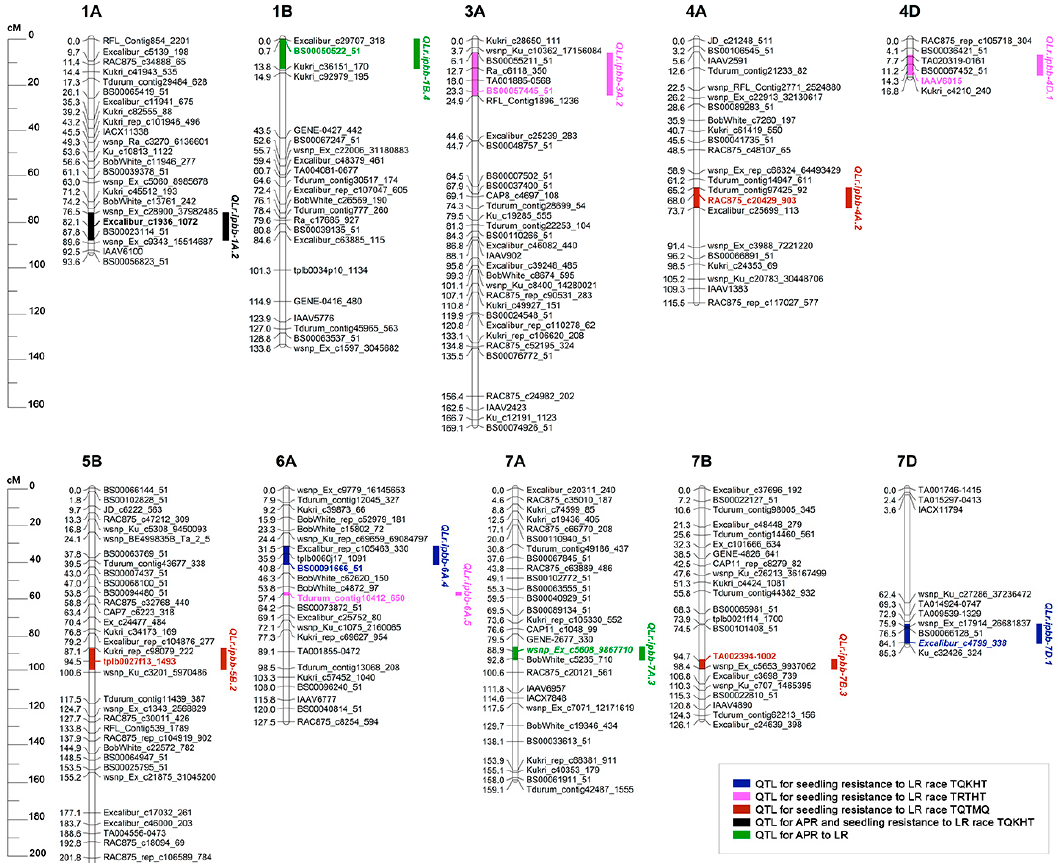
Table 6. Correlations between leaf rust (LR) and stem rust (SR) resistance at the adult plant stage and yield-related traits in the Pamyati Azieva × Paragon mapping population.